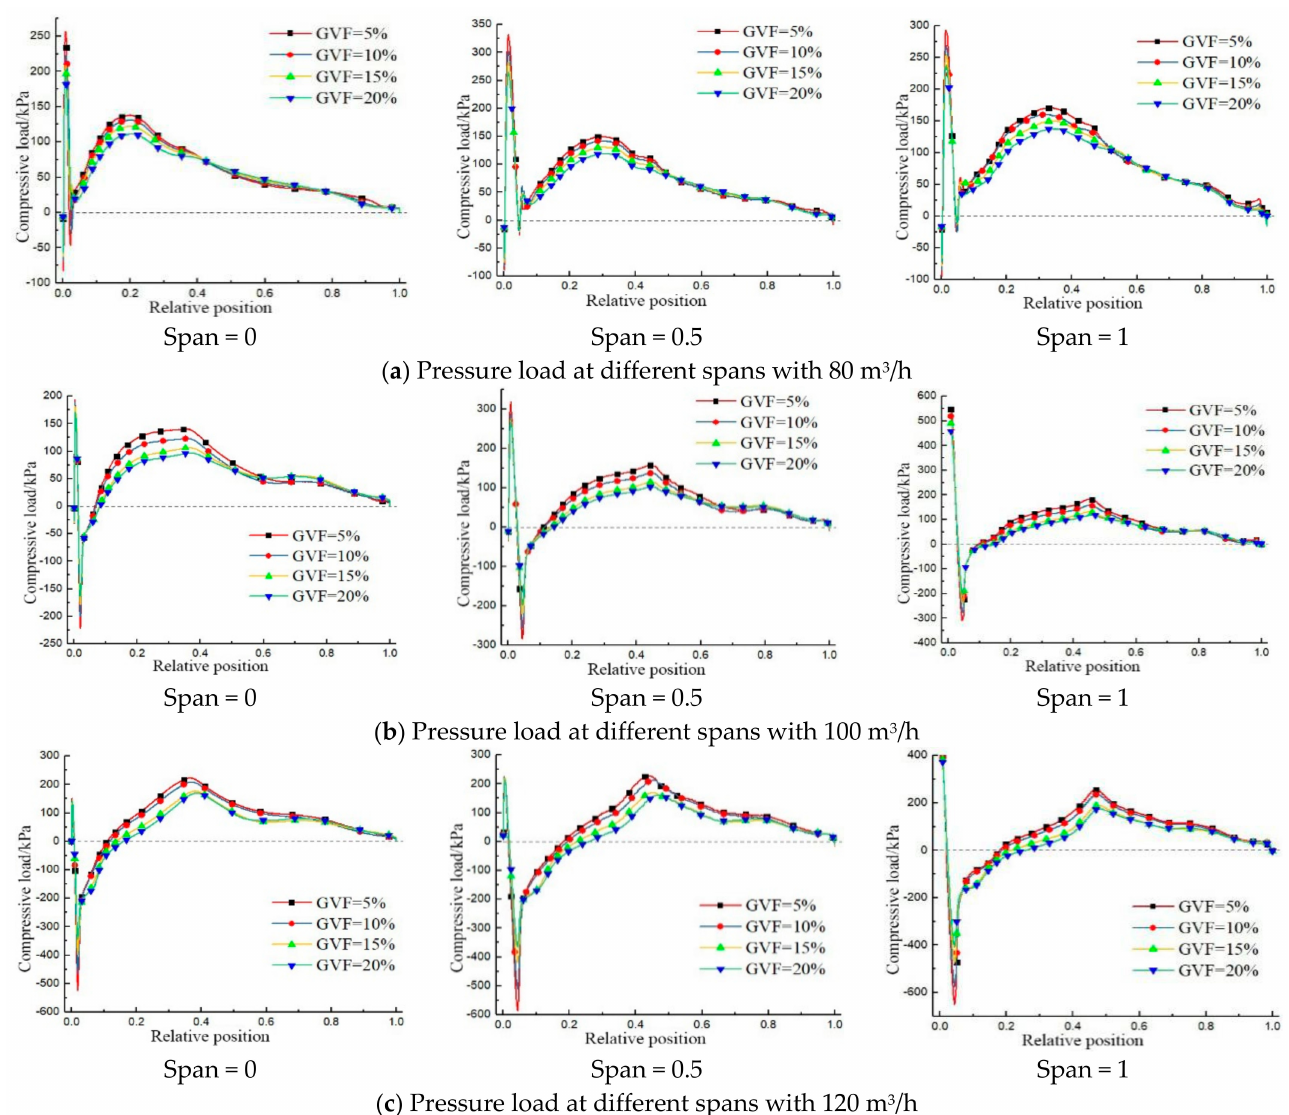
Figure 12. Pressure load distribution curve of multiphase pump under various